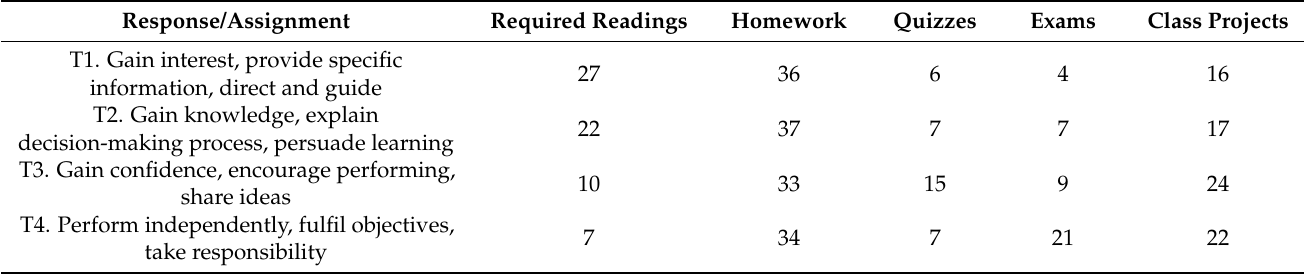
Table 7. Average percentage of responses for the most helpful assignments (excluding blank, void, and other responses). Response/Assignment